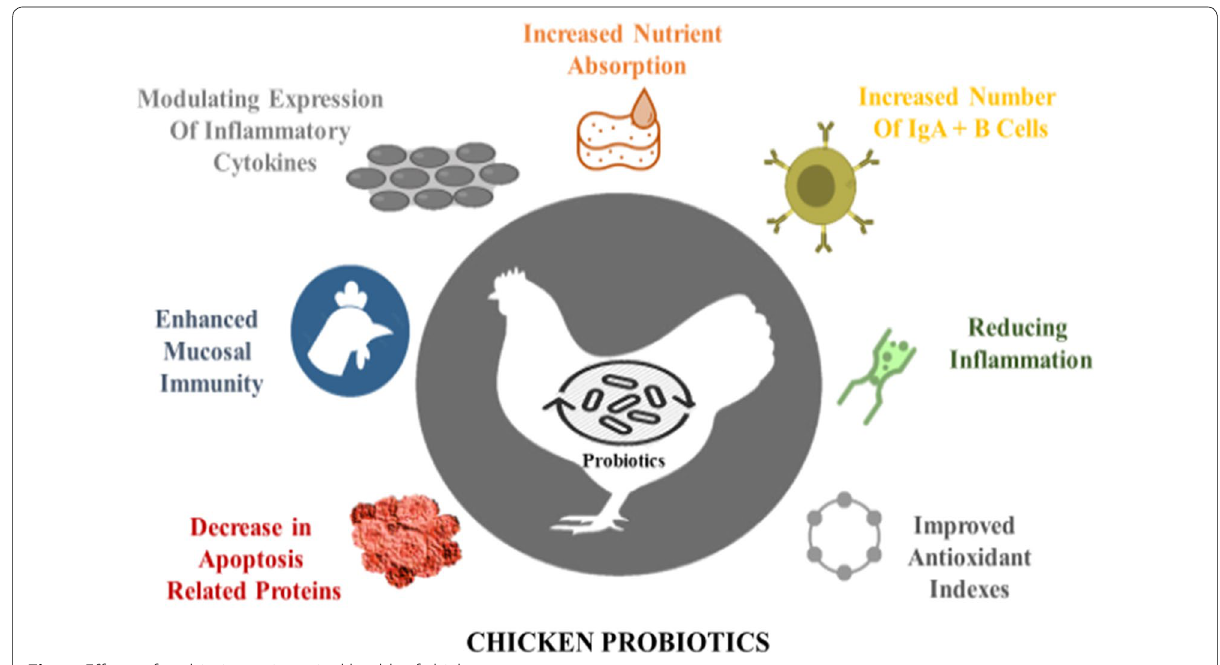
Fig. 1 Effects of probiotics on intestinal health of chickens